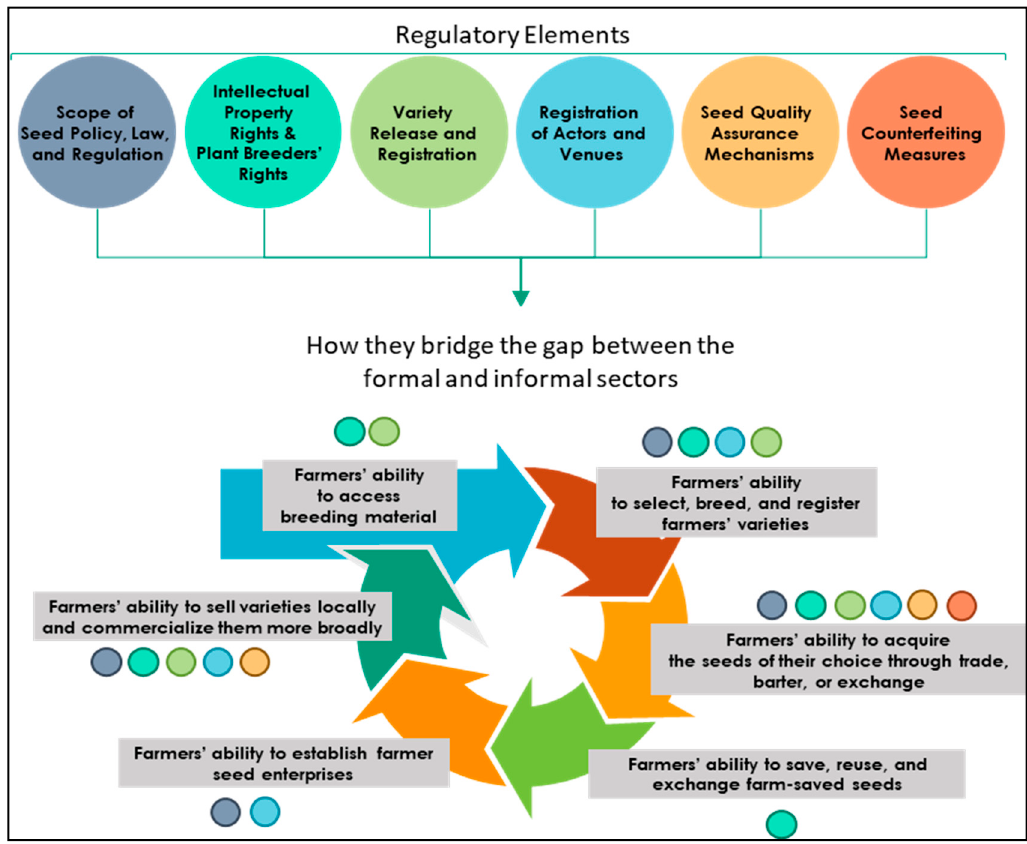
Figure 2. Relationship between regulatory elements and link between informal and formal seed sectors (adapted from [2,9]).